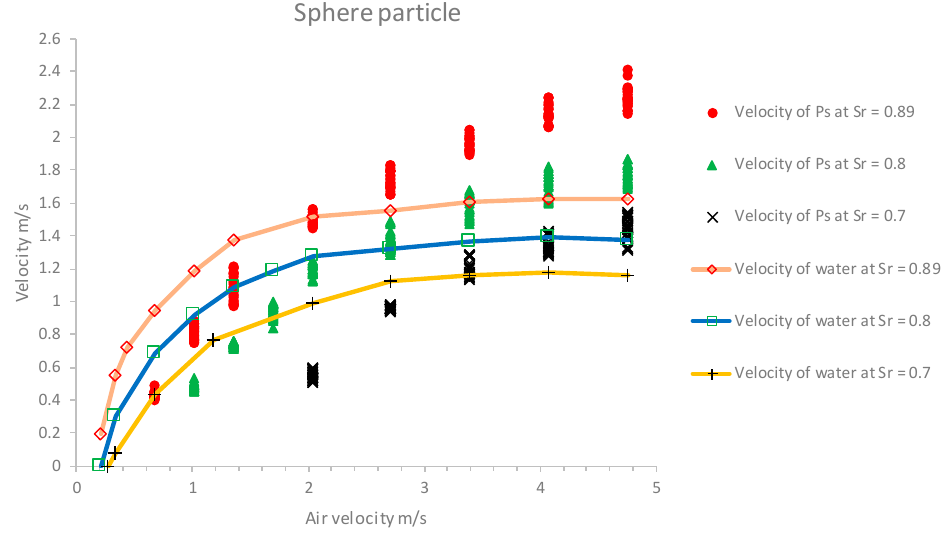
Figure 6. Effect of the submergence ratio on the solid particle transportation.